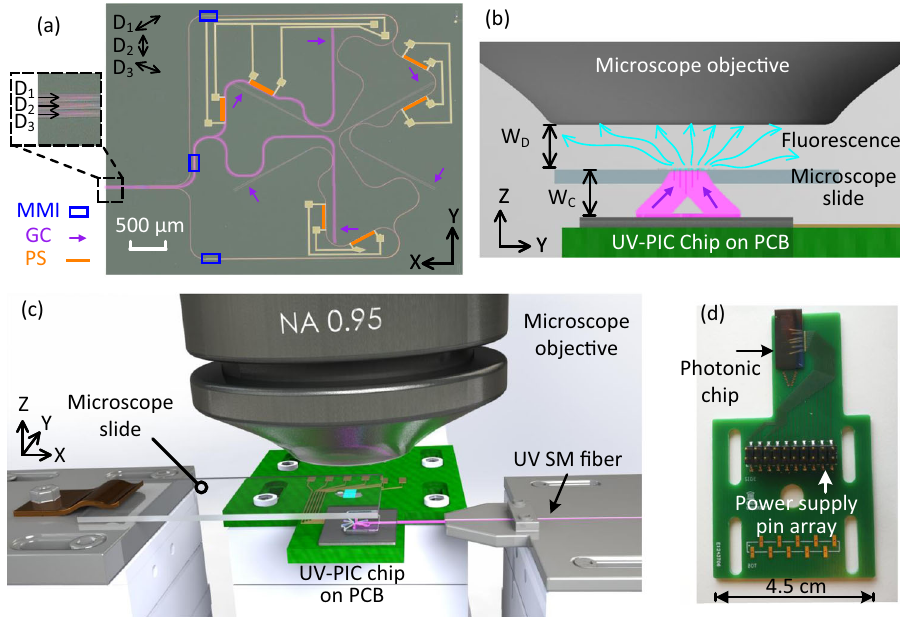
Fig. 1 | Working principle of the UV-PIC SIM. a Picture of a UV photonic inte- grated circuit for structured illumination microscopy. MMI: multimodal inter- ferometer (blue), GC: grating out-coupler (violet) and PS: thermal-phase shifter (orange). D 1 , D 2 , and D 3 indicate three different optical paths corresponding to structuredilluminationdirectionsturnedatanangleof120degrees.Lightpurple path: D 2 . b Working principle of the UV-PIC-based SIM technique. W D : working